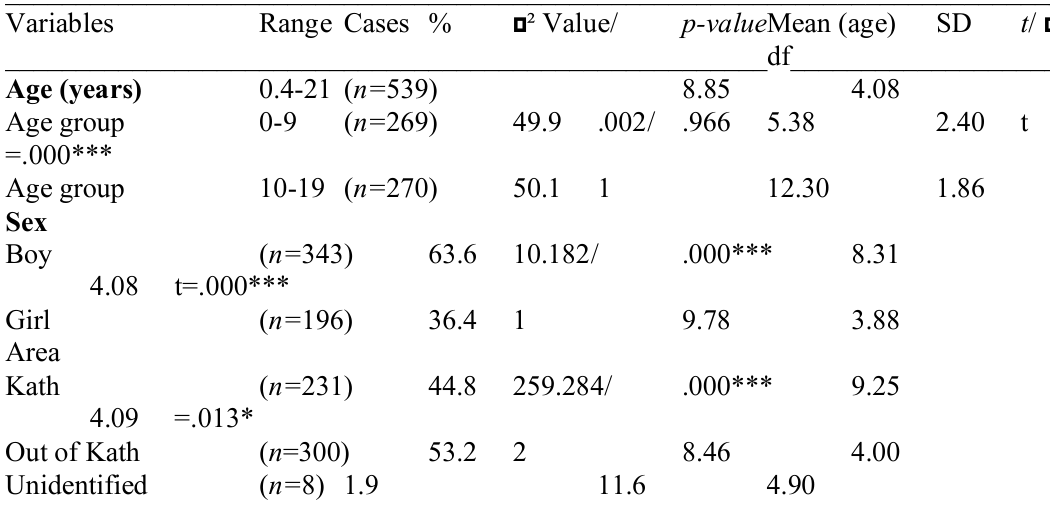
Figure 1: Chi2 test and Anova Significance p<.05*, p<.01**, p<.001***